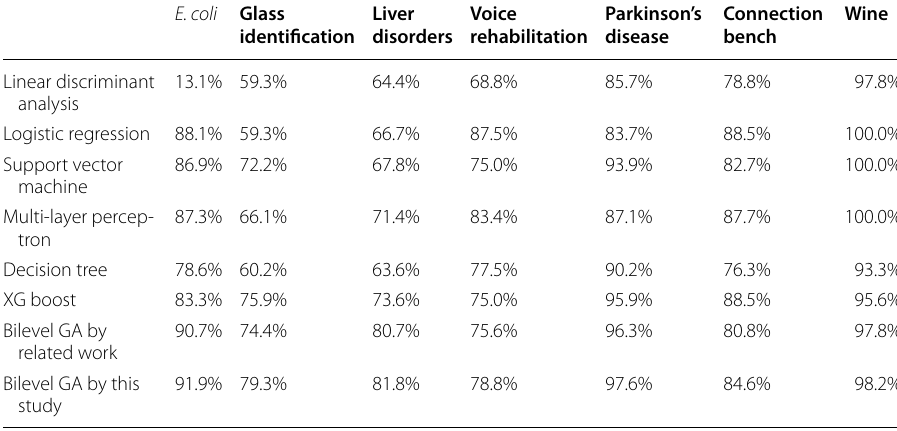
Table 3 Accuracy comparison of classification problems